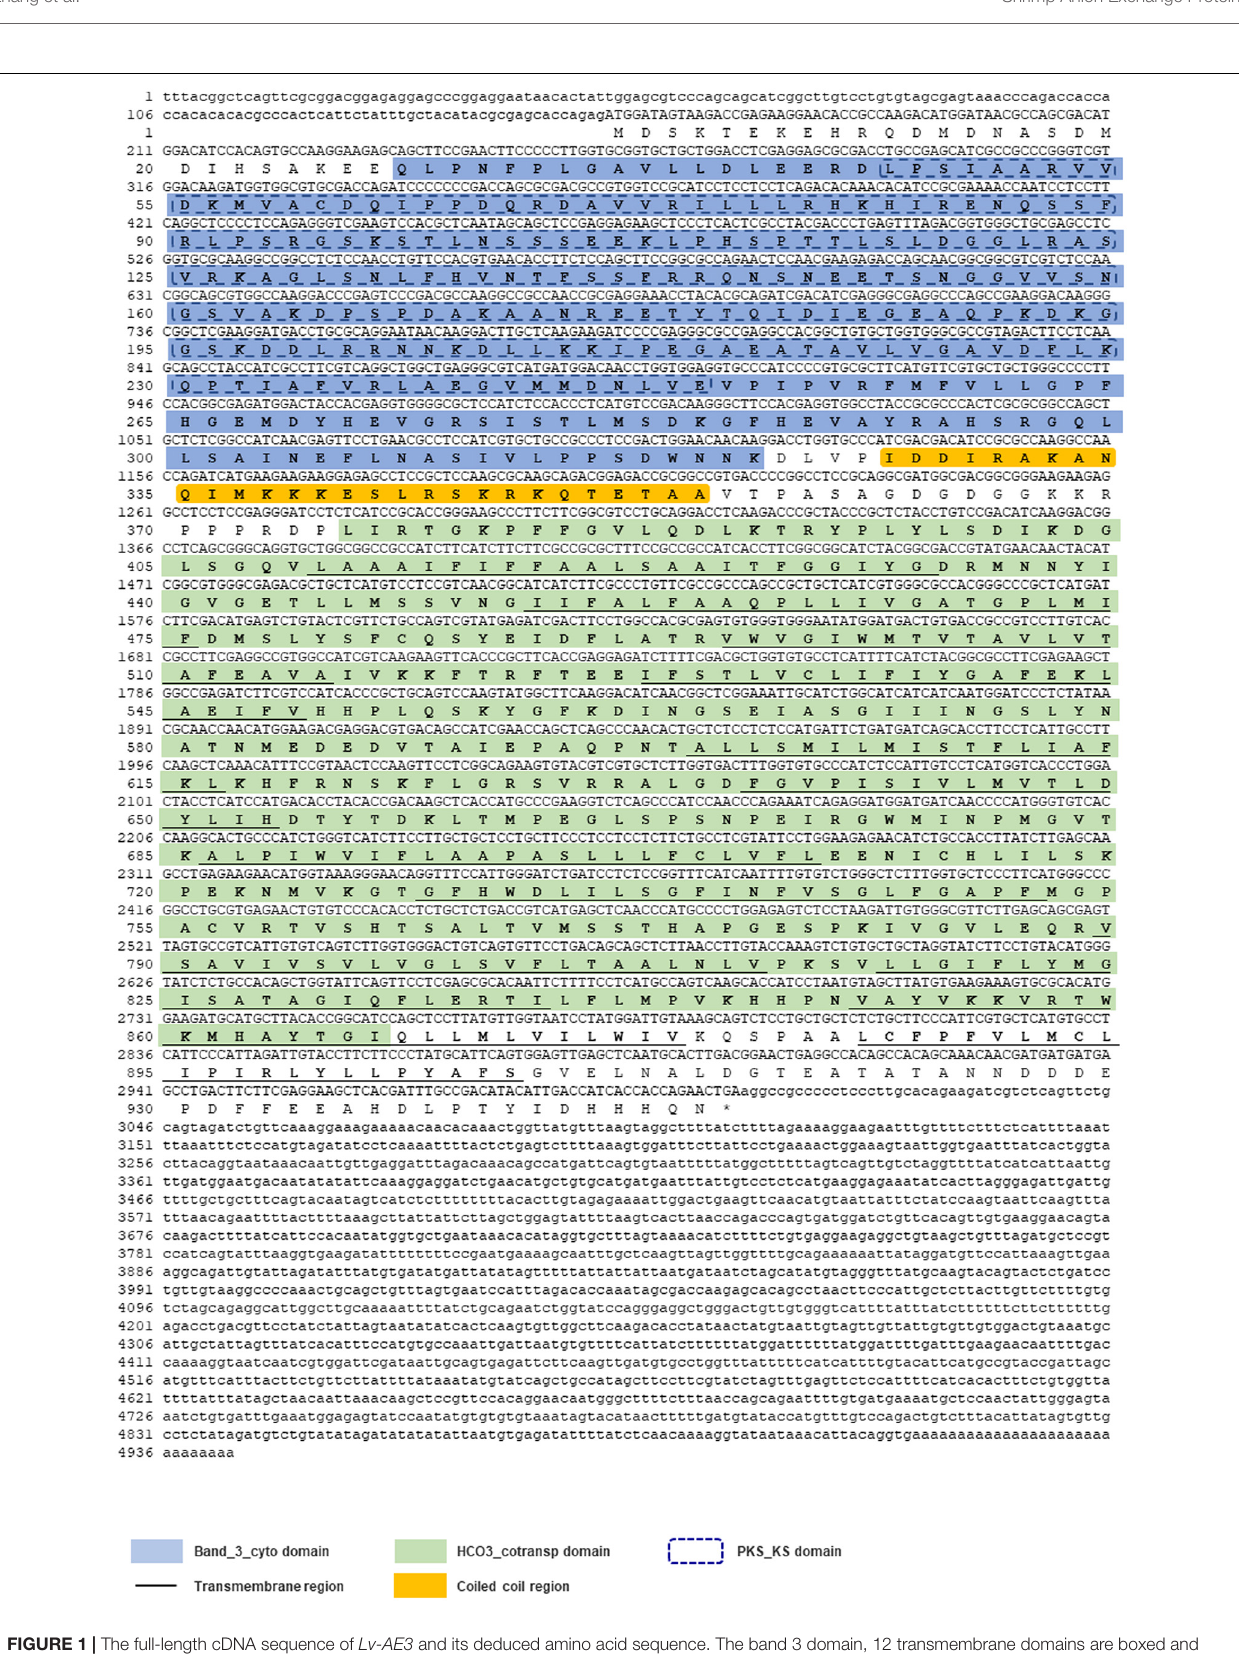
Frontiers in Physiology |